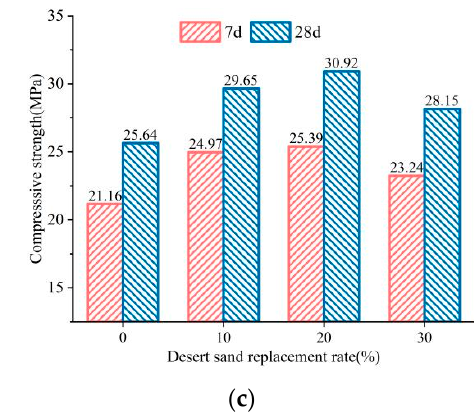
Figure 6. The relationship between the DS replacing ratio and the FDCC performance: ( a ) slump; ( b ) apparent density; ( c ) compressive